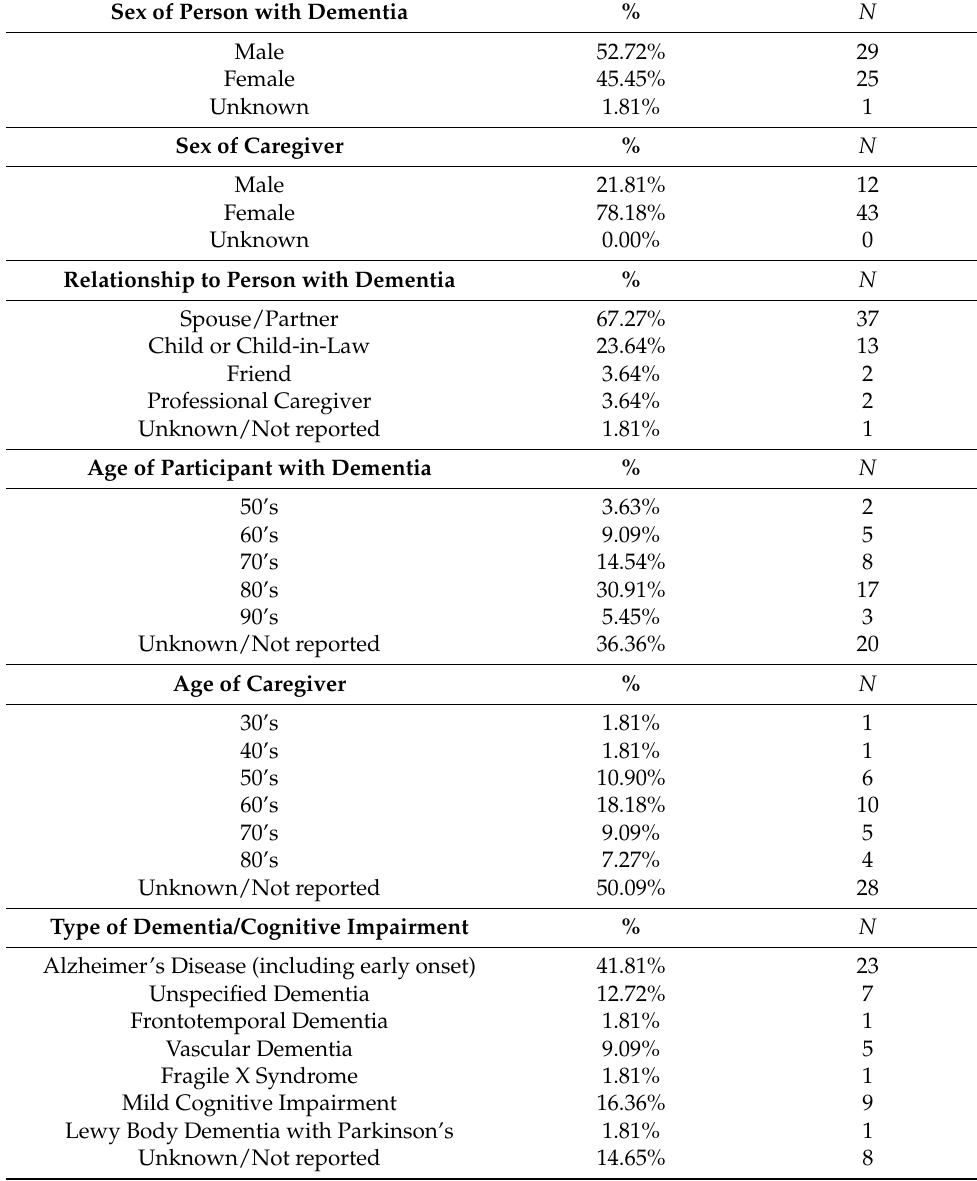
Table 1. B Sharp Participant Demographic